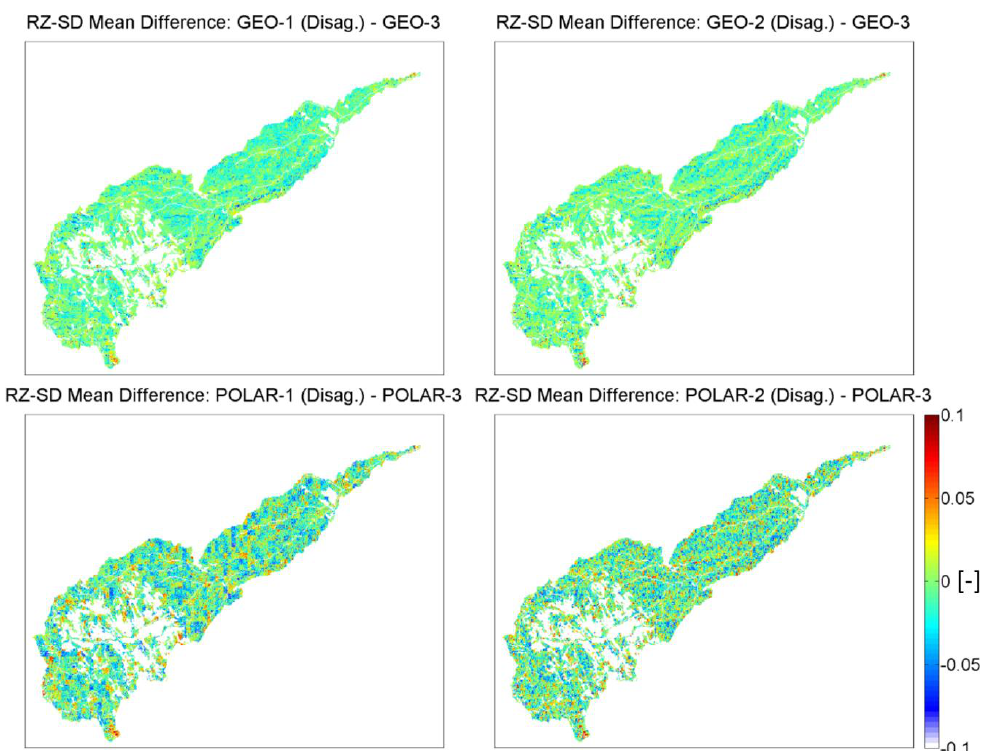
Figure 7. The figure shows the different maps obtained by subtracting the mean RZ-SD maps of the GEO-3 and POLAR-3 products from the mean RZ-SD maps of the SM disaggregated